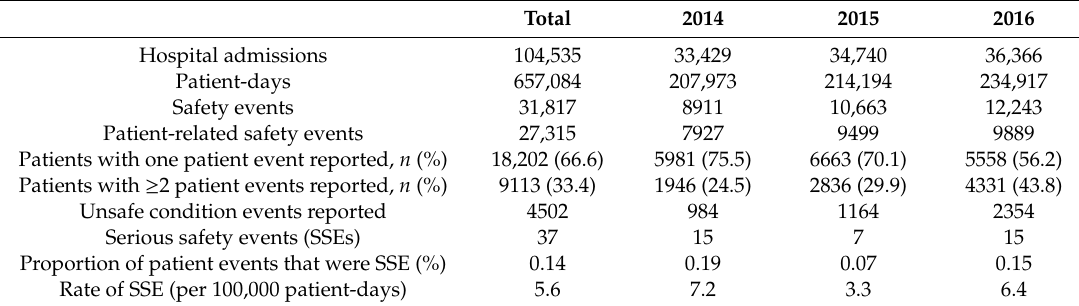
Table 2. Reported safety